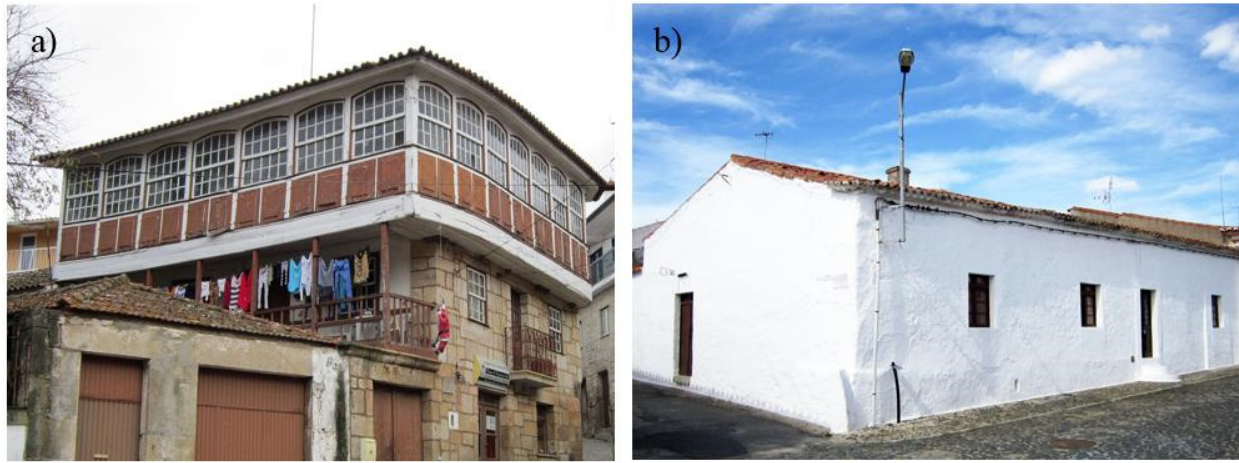
Figure 2. ( a ) Northern building with glazed-balcony; ( b ) Southern rammed-earth